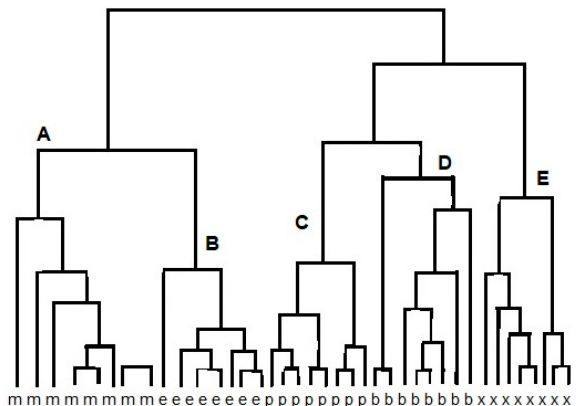
Figure 1. Result of principal component analysis (PCA) (PC1 vs. PC2) analysis of e-nose response on banana volatile compounds. Clusters were determined according to the increasing ripeness of the fruit (a–g).